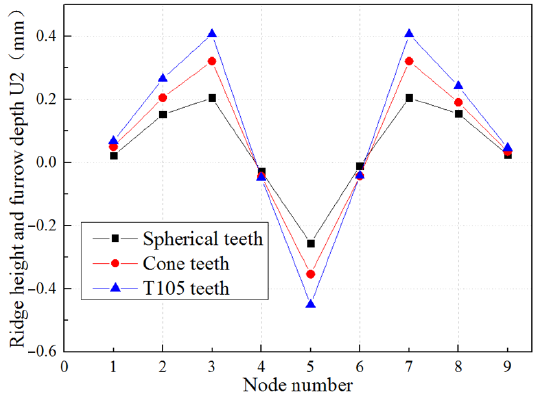
Figure 11. Ridge height and depth of single